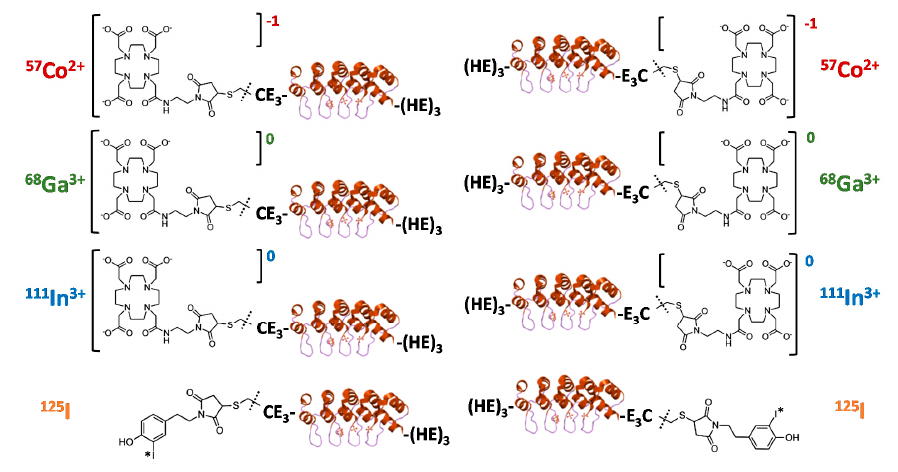
Figure 1. Schematic overview of the structures of Ec1 variants radiolabeled with cobalt-57, gallium-68, indium-111 or iodine-125 at the N- or C-terminus.